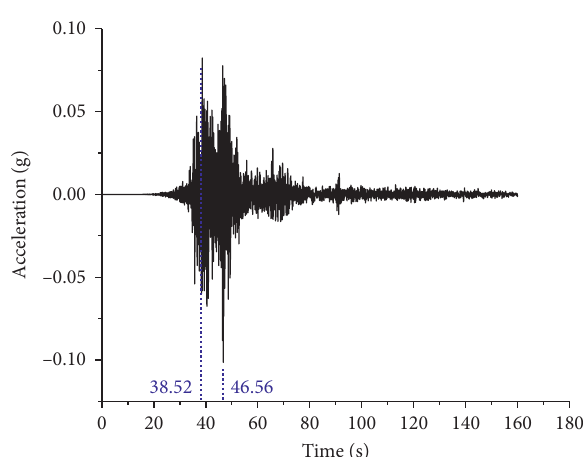
Figure 7: Acceleration time history curve of WC seismic wave.